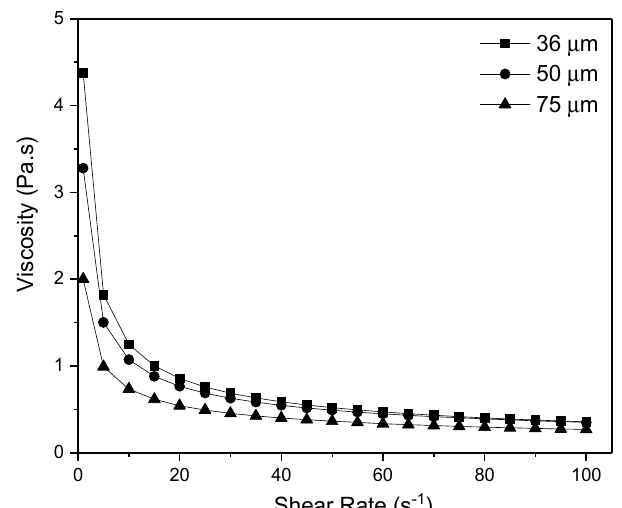
Figure 2. Rheological profile of suspension containing zeolite/NMP/PESf/Arlacel with different sizes of zeolite particle.